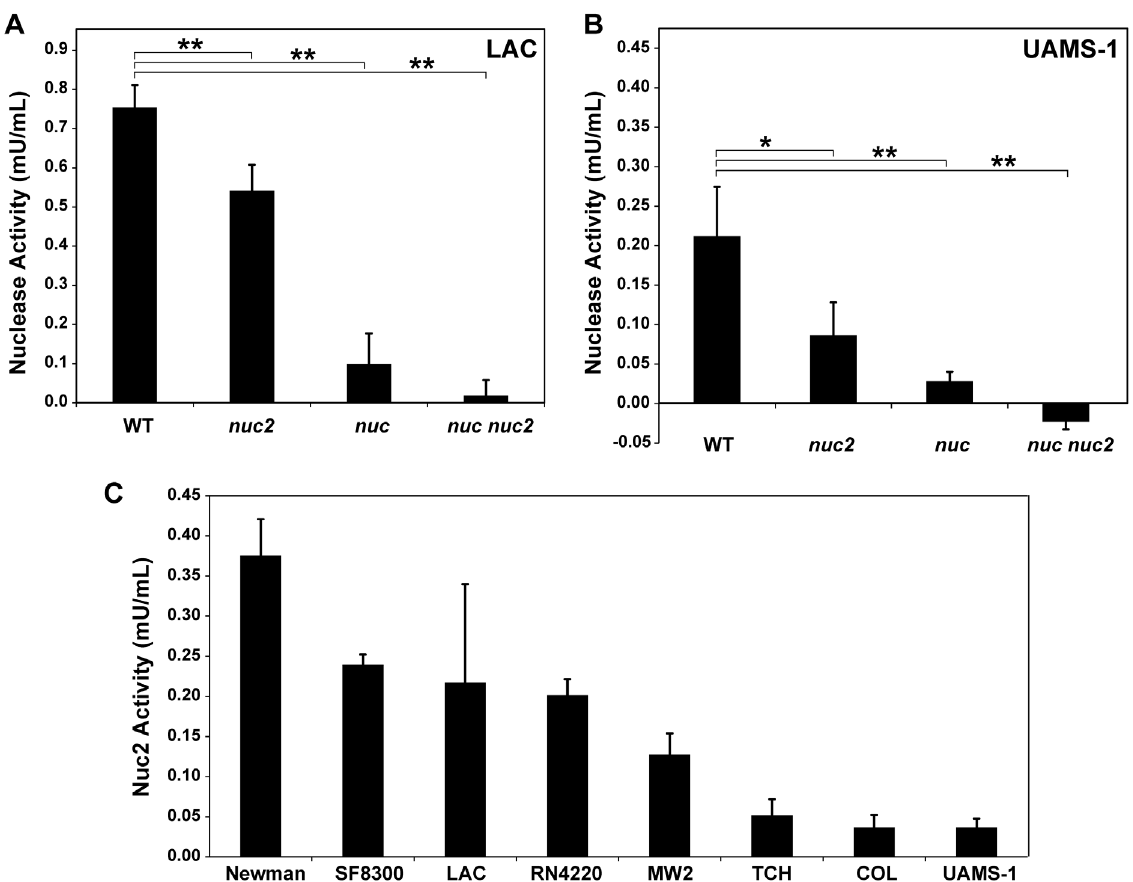
Figure 3. Nuc2 activity can be measured at the cell surface. A . Whole-cell FRET activity assay measuring Nuc2 surface function with UAMS-1 WT, nuc2 , nuc and nuc nuc2 double mutants. B . Cell surface nuclease activity in USA300 strain LAC WT, nuc2 , nuc and nuc nuc2 double mutants. Statistical significance (*p , 0.1; **p , 0.01) was determined by a Student’s T-test. C . A collection of S. aureus nuc mutants tested in the same whole-cell FRET assay. The strains represented several genetic backgrounds, including (from left) Newman, USA300 strains (SF8300 and LAC), RN4220, MW2, TCH1516, COL and UAMS-1.